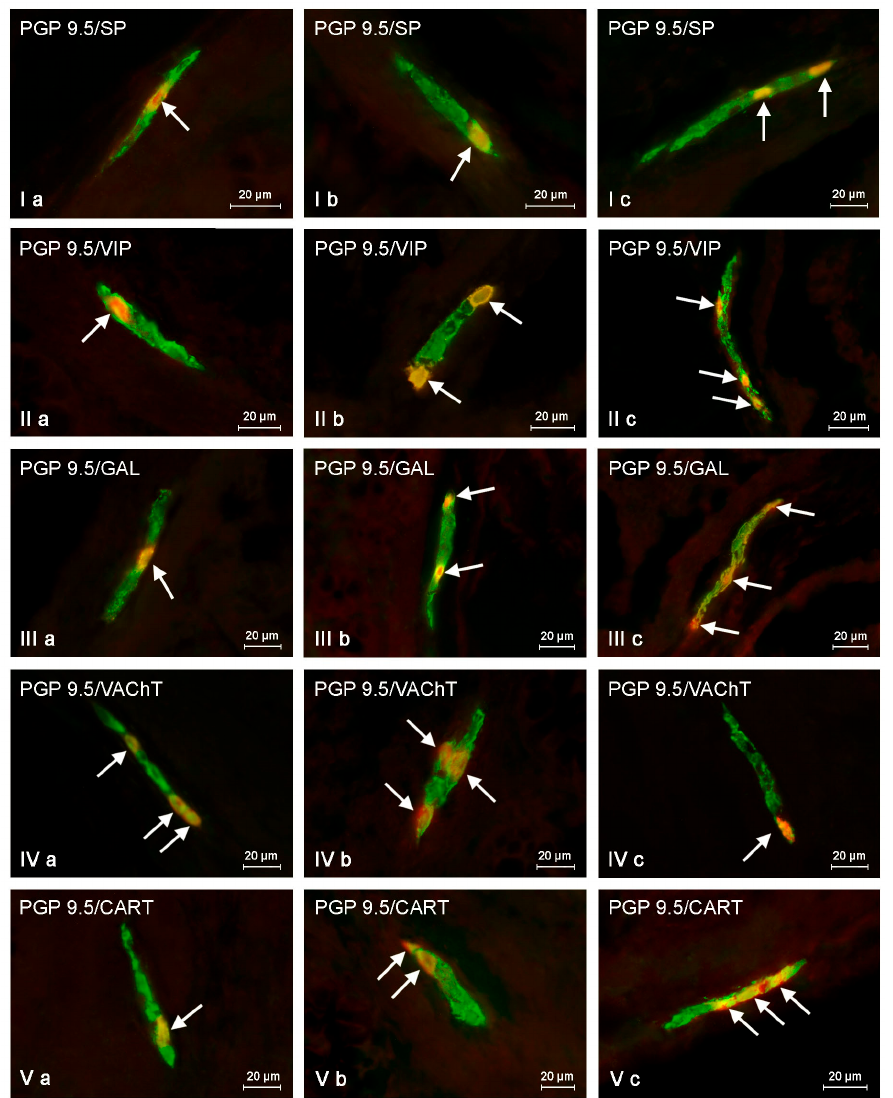
Figure 5. Inner submucous plexus in control animals ( a ) and after BPA treatment in low ( b ) and high ( c ) doses, immunostained for protein gene product 9.5 (PGP 9.5—used here as a pan-neuronal marker) and other neuronal factors including substance P (SP), vasoactive intestinal polypeptide (VIP), galanin (GAL), vesicular acetylcholine transporter (VAChT—used here as a marker of cholinergic neurons), and cocaine- and amphetamine-regulated transcript peptide (CART). Neurons showing co-localization of PGP 9.5 and other neuronal factors are indicated with arrows.